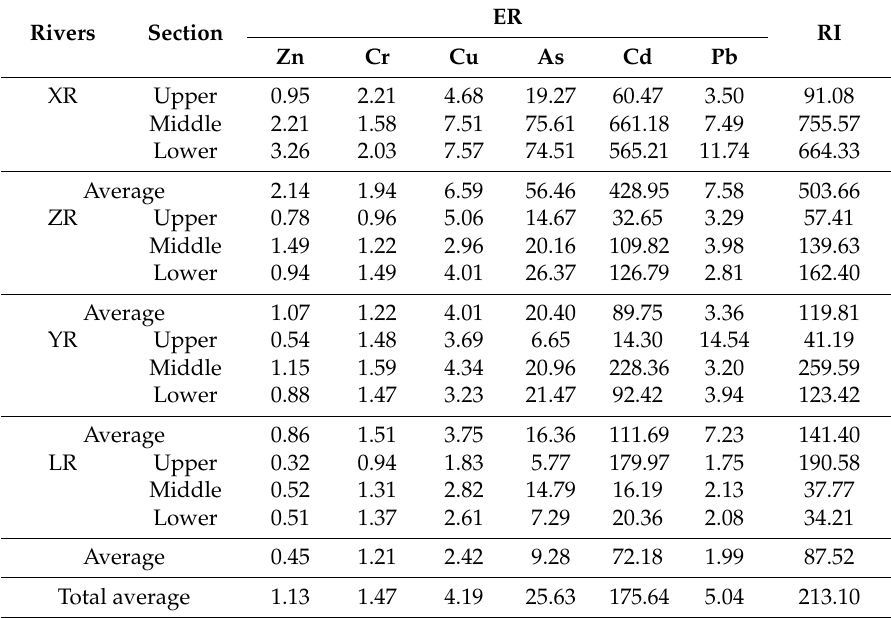
Table 5. The potential ecological risk index of analyzed metals in river sediments.